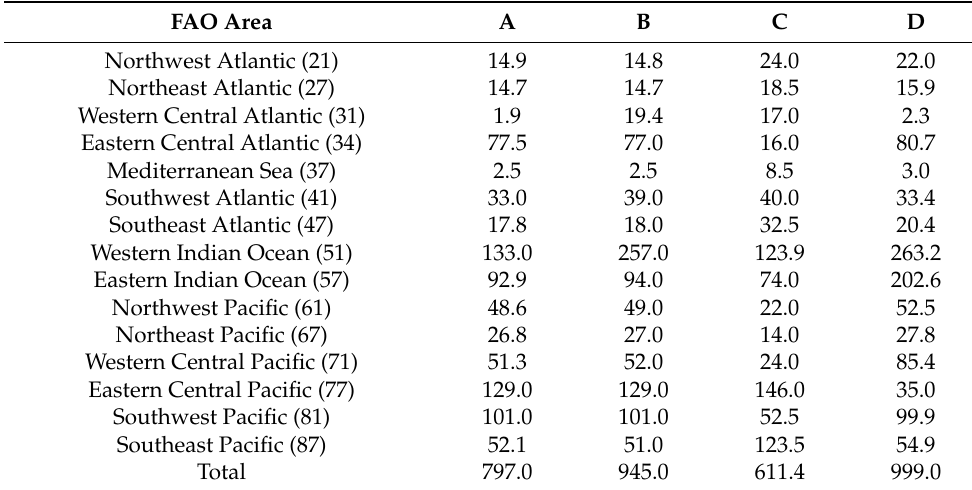
Table 3. Biomass of mesopelagic fishes (millions t) by FAO Statistical Area, as estimated by Gjøsaeter and Kawaguchi [2] (G&K) in columns A (G&K’s estimates in tables) and B (G&K’s estimates in text), C (Tseilin’s [18] averaged from lower and higher limits of biomass estimates), and by Lam and Pauly [19] in column D (new